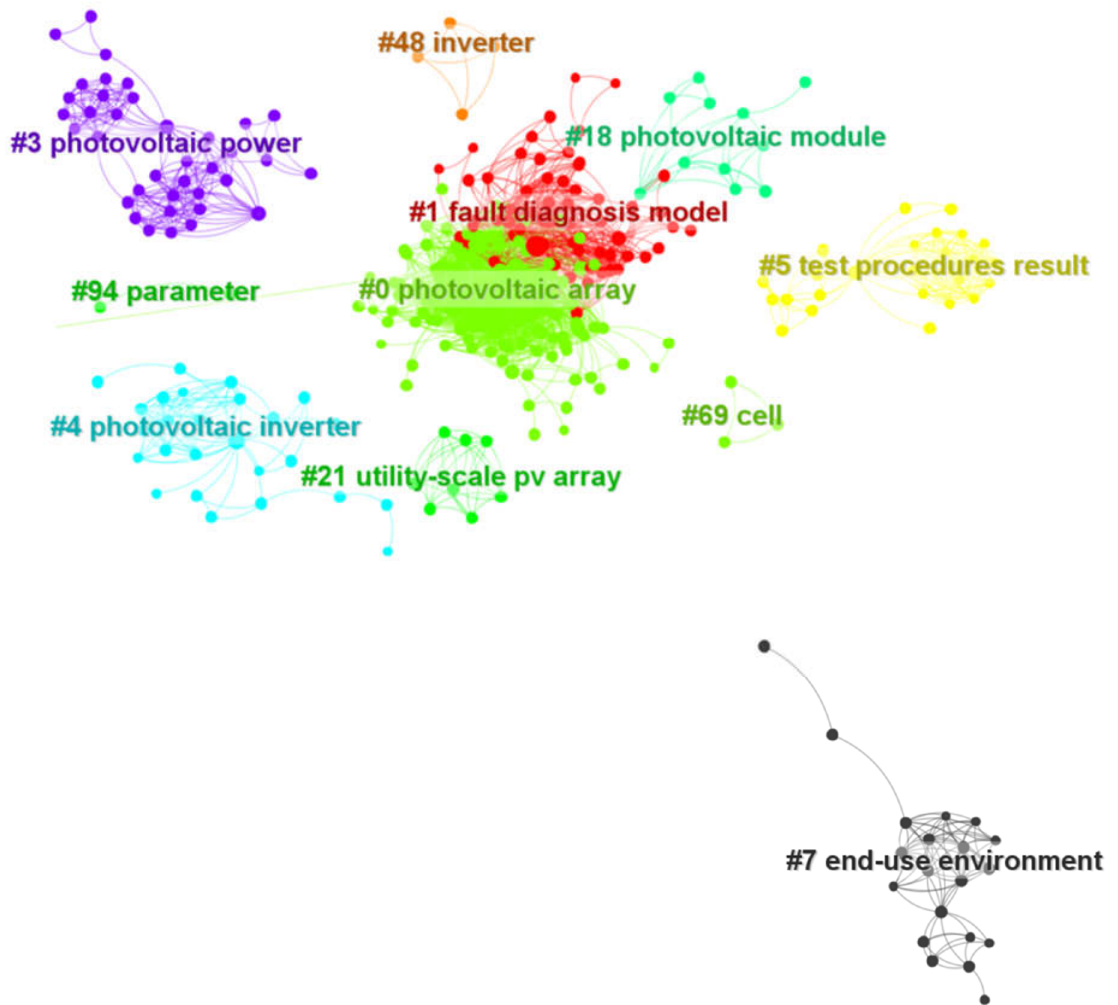
Figure 5. Citation analysis. Table 2. Main research interests.